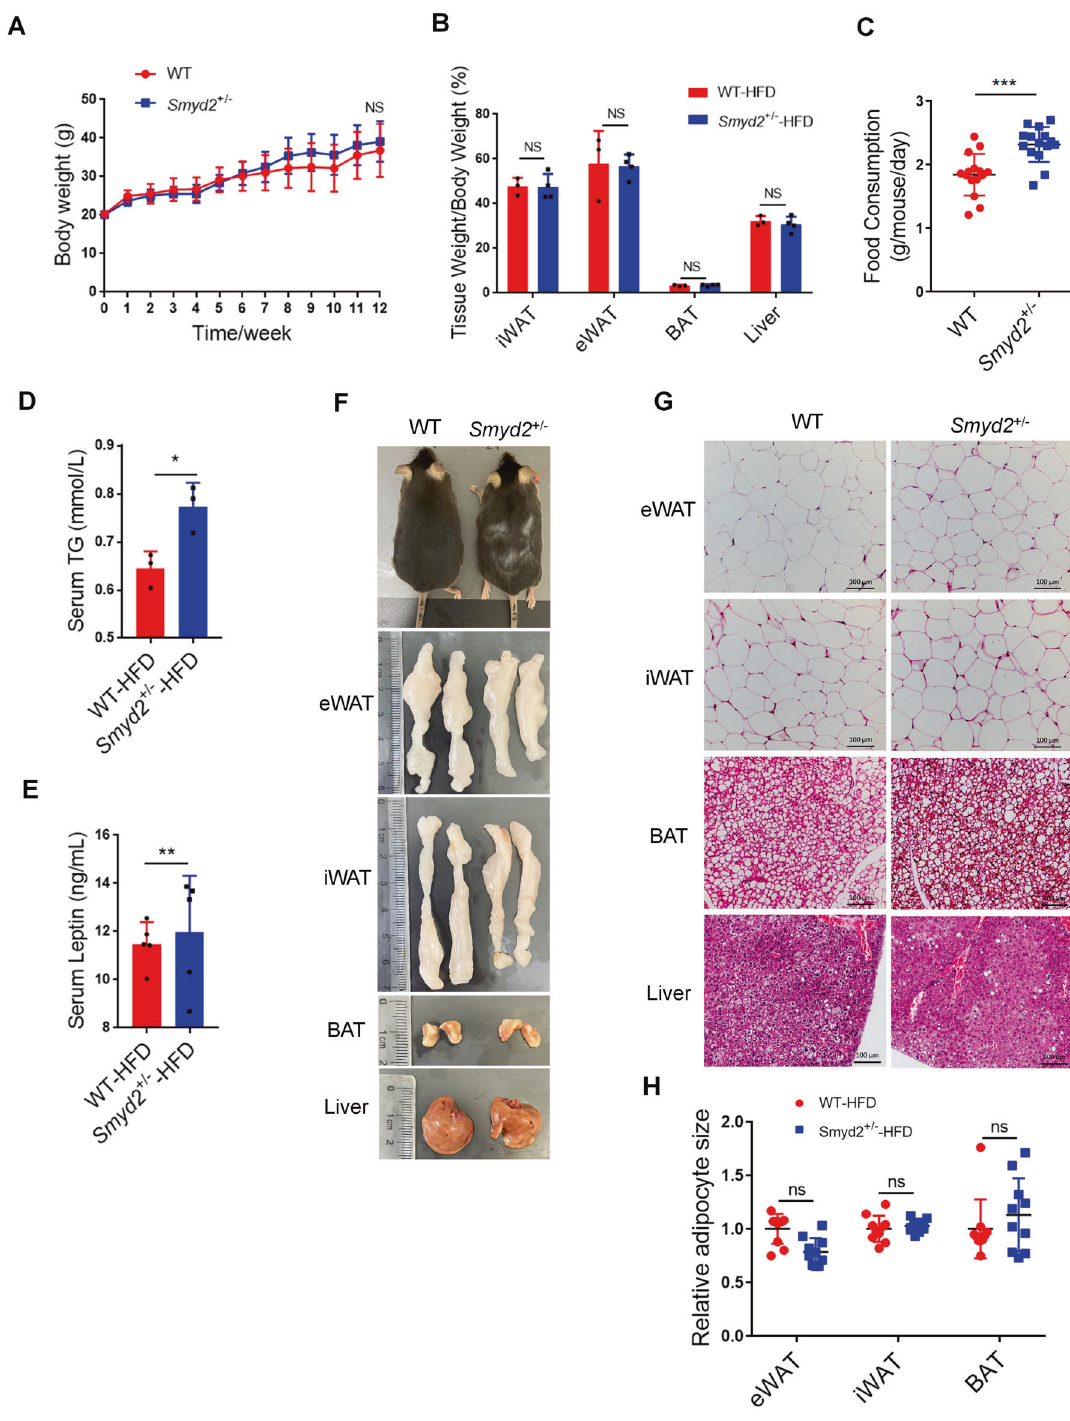
Fig. 7 Smyd2 + / − mice are not susceptible to HFD-induced obesity. A Body weights of HFD-fed WT and Smyd2 + / − mice were measured each week for 12 weeks ( n = 7). B The ratio of fat pad weight and body weight of HFD-fed WT and Smyd2 + / − mice. C The food consumption of WT and Smyd2 + / − mice upon HFD for 12 weeks. D, E The serum TG and leptin levels were detected after 12 weeks of HFD feeding. F Representative images of mice and the fat pads and liver from WT and Smyd2 + / − mice after 12 weeks of HFD feeding. G, H Histological analysis of eWAT, iWAT, BAT, and liver from WT and Smyd2 + / − mice after 12 weeks HFD feeding and then the adipocyte areas were measured. Scale bar, 100 μ m. Data are presented as mean ± SD. * p < 0.05, ** p < 0.01, *** p < 0.001. Smyd2 + / − mice was signi fi cantly upregulated than that of WT level of leptin, which is a protein-like hormone secreted by adipose tissues [24]. Our previous results showed that ND-fed mice (Fig. 7E), suggesting that Smyd2 + / − mice fed by HFD may be Smyd2 + / − mice showed much less leptin level than WT mice (Fig. under the leptin resistance. Therefore, we investigated the canonical JAK2-STAT3 signaling pathway, which is activated by 6F), while after 12 weeks of HFD feeding, the serum leptin level of